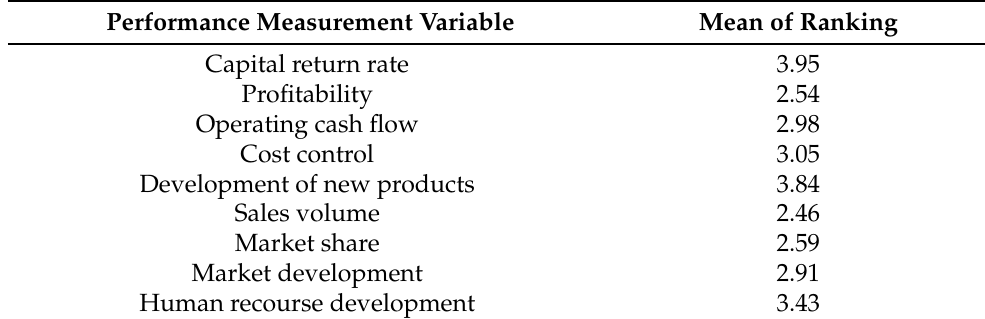
Table 15. Mean of ranking in tested dimensions in performance measurement variable based on Kruskal–Wallis test.